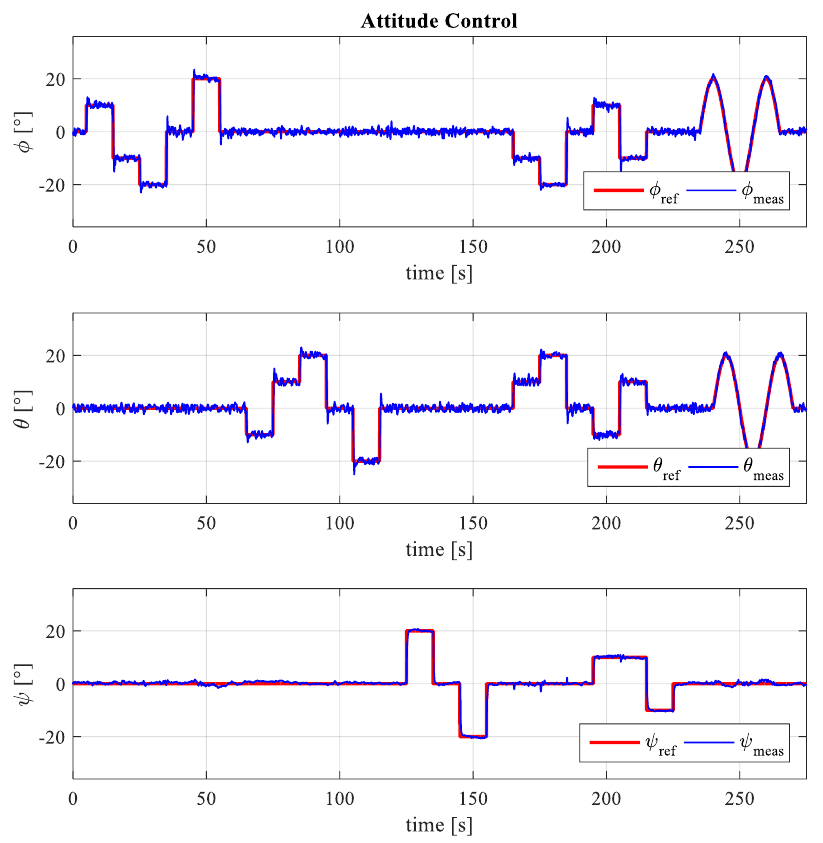
Figure 13. Experimental results of PTX6 configuration response for attitude control.